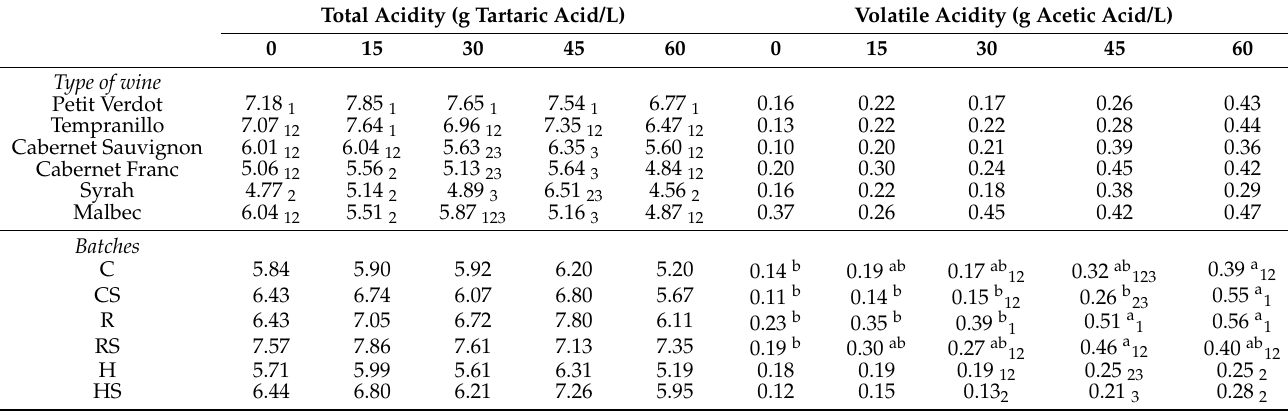
Table 5. Evolution of total acidity (g tartaric acid/L) and volatile acidity (g acetic acid/L) during wine storage (C: control batch, CS: control batch with sulfur dioxide; R: batch of scratch, RS: batch of scratch plus sulfur dioxide, H: batch of skin and HS: batch of skin plus sulfur